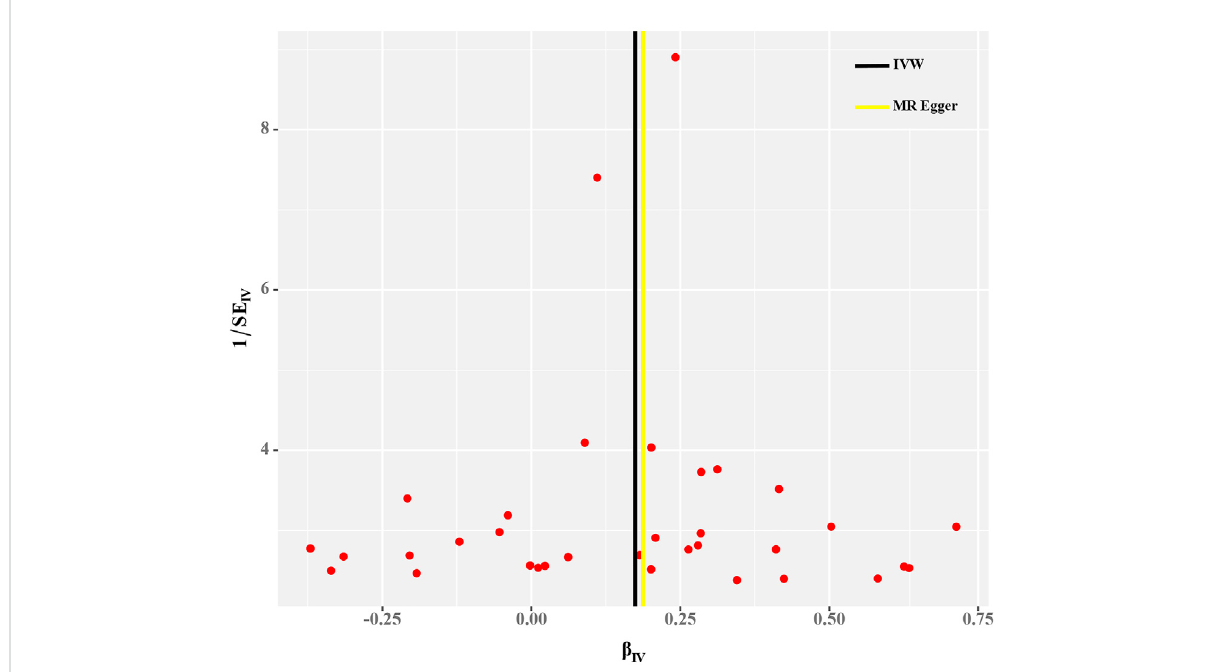
FIGURE 3 Funnel plot for the causal estimates of each tea SNP with